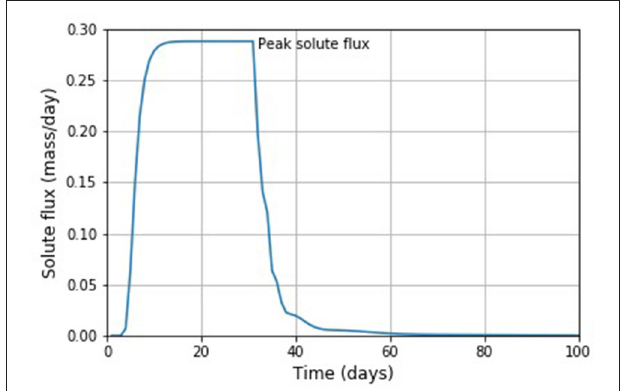
FIGURE 4 | Average breakthrough curve (BTC) derived from 1,000 stochastic HYDRUS-1D